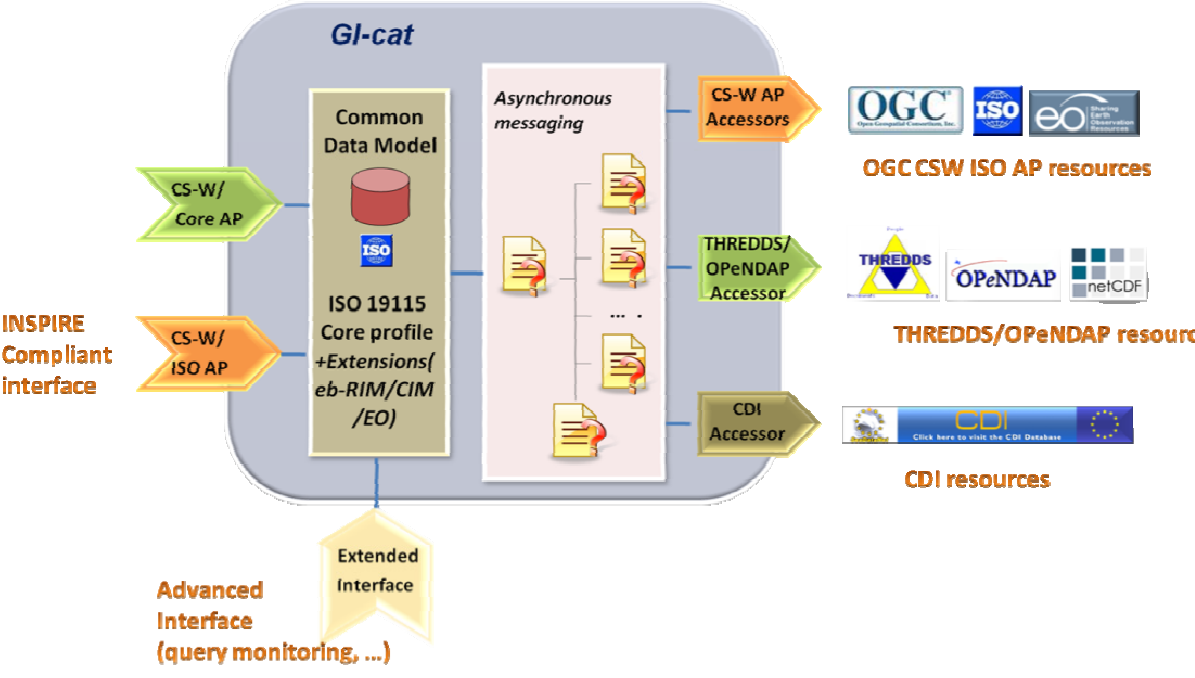
Figure 9: The system developed to run interoperability tests 8 Fig. 9. The system developed to run interoperability